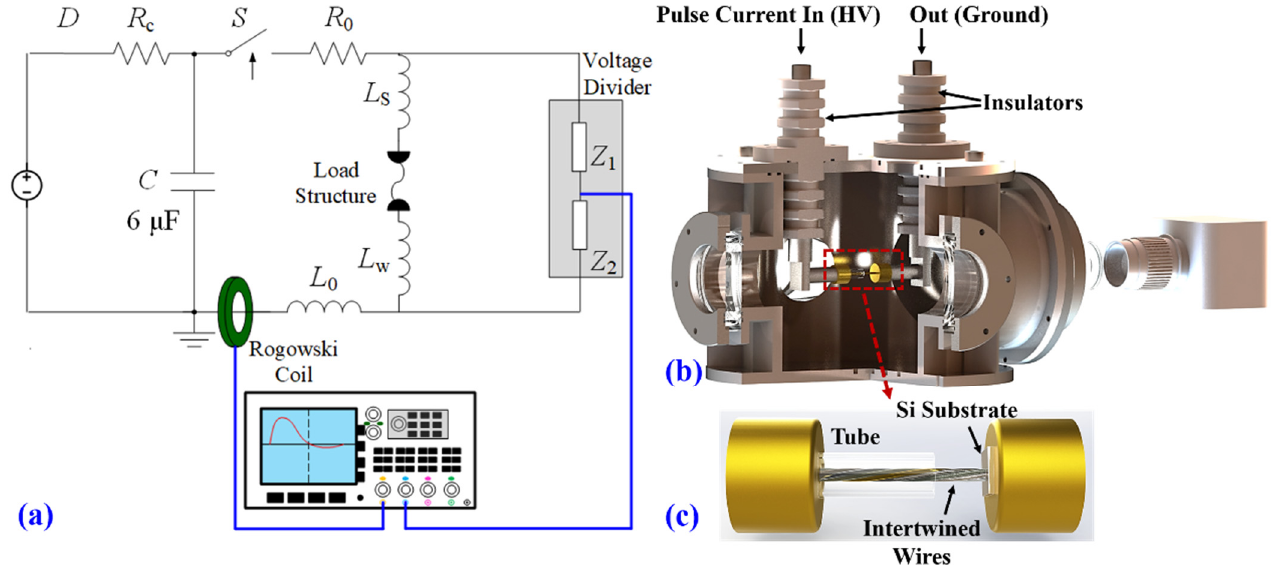
Figure 1. Schematics of the experimental setup and configurations: ( a ) circuit diagram; ( b ) cross- sectional view of the chamber; and ( c ) detailed drawing of the directional spraying device.